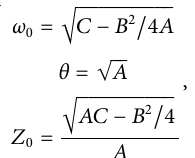
Where ω ( z ) corresponds to the radius of the spot at position z . A , B , and C are the three coef fi cients obtained from the least squares fi t; each parameter of the laser can be expressed by A, B, and C, respectively, as